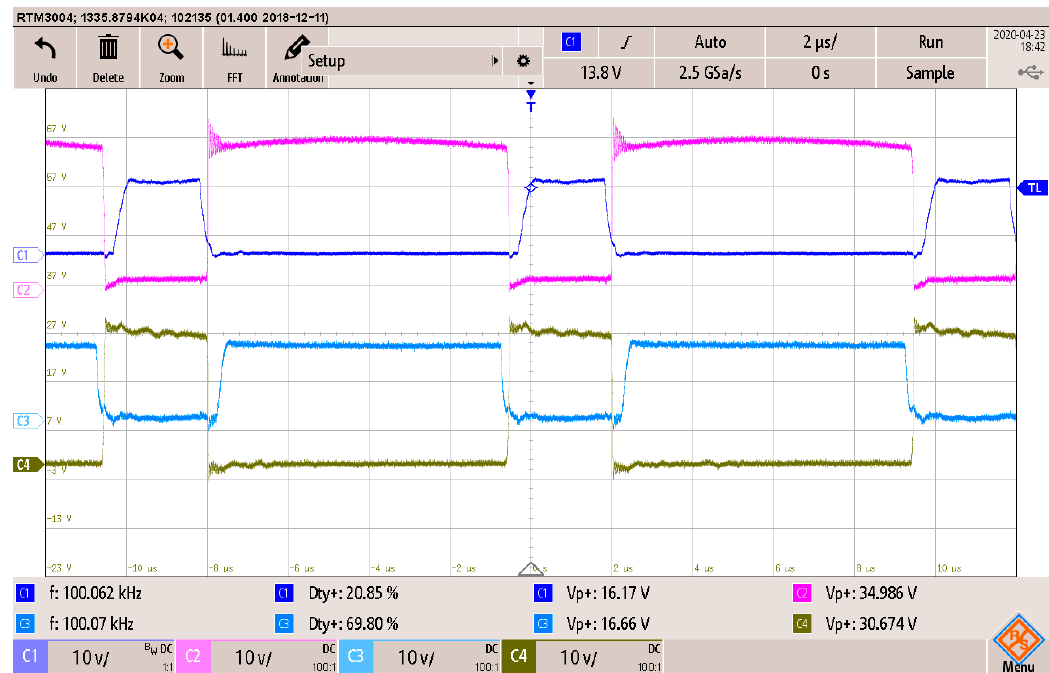
Figure 21. Waveforms of switch V GS and V DS with input of 40 V and output of 12 V/1 A. (CH1, V GS 1 ; CH2, V DS 1 ; CH3, V GS 2 ; CH4, V DS 2 ).